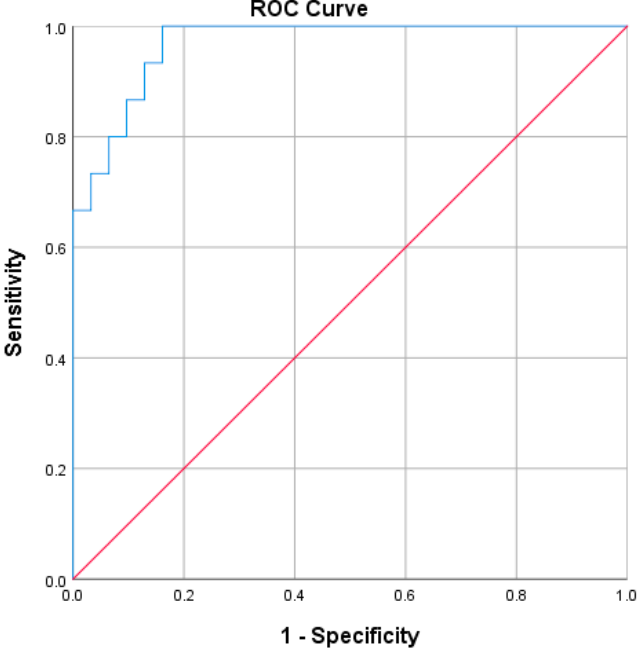
Figure 1. ROC curve of the predictive model for EDSS-plus score progression in the first year following diagnosis of RRMS.